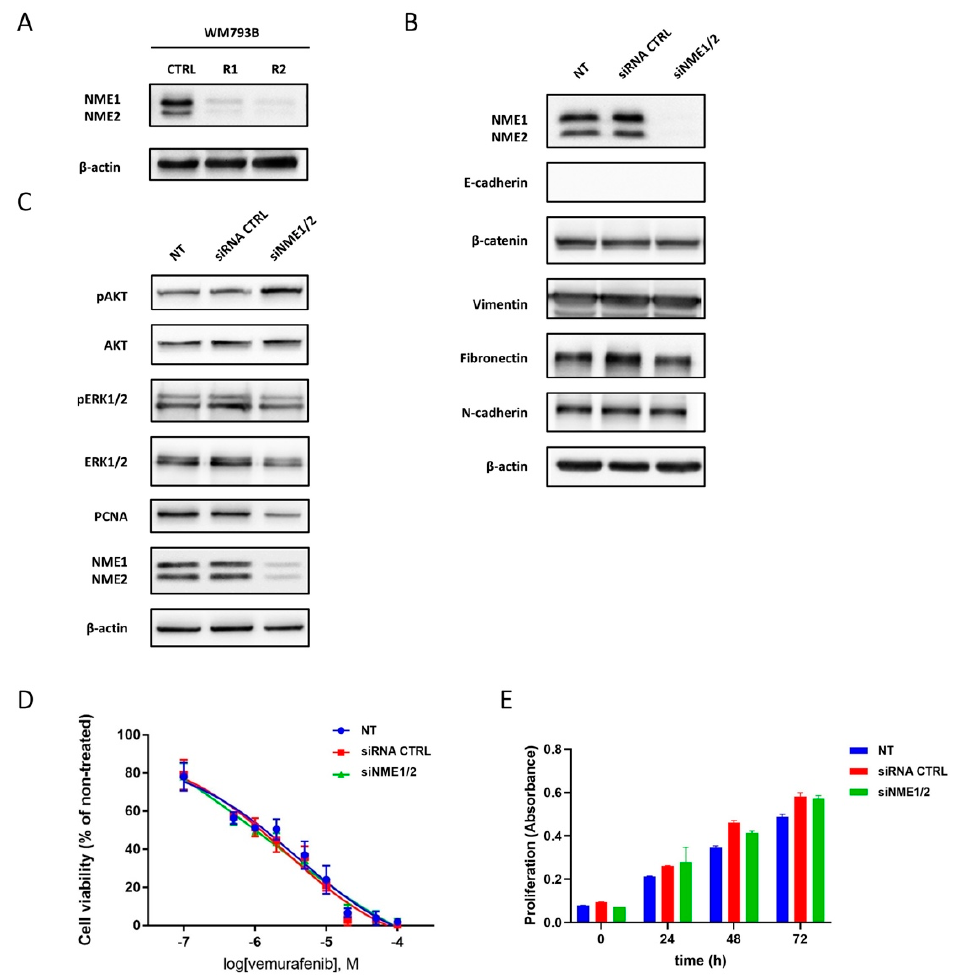
Figure 8. Silencing of NME1 and NME2 activates PI3K/AKT signaling pathway in WM793B cell line. Protein expression of NME1 and NME2 is reduced in vemurafenib-resistant WM793B cell line compared to parental line ( A ). Expression of EMT markers ( B ), signaling pathway, and proliferation markers ( C ) after silencing of NME1 and NME2 protein expression in WM793B cell line. Untreated samples (NT), samples transfected with the control siRNA (CTRL siRNA), and samples silenced with siNME1 and siNME2 (siNME1/2) were analyzed by western blot. β -actin was used as a loading control. A representative western blot from at least three experiments (three biological replicates) is shown. The viability of WM793B cells at increasing concentrations of vemurafenib was measured by MTT assay ( D ). The viability of untreated cells (NT), cells after transfection with control siRNA (CTRL siRNA), and cells after silencing of NME1 and NME2 protein expression (siNME1/2) is shown. The mean values of three biological replicates with standard deviations are shown. Each biological replicate was prepared in triplicate. The proliferation rate of untreated primary melanoma WM793B cells (NT), after transfection with control siRNA (CTRL siRNA), and cells after silencing of NME1 and NME2 protein expression (siNME1/2) ( E ). The mean values of two biological replicates with standard deviations are shown. Each biological replicate was prepared in triplicate.